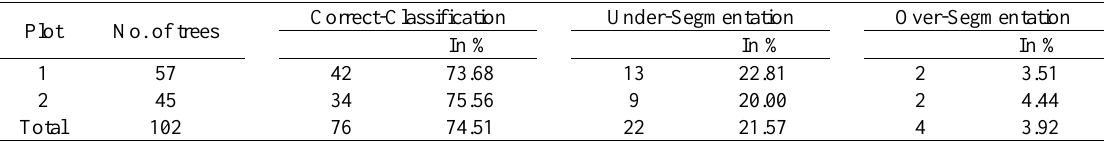
Table 4. Segmentation results compared to aerial image